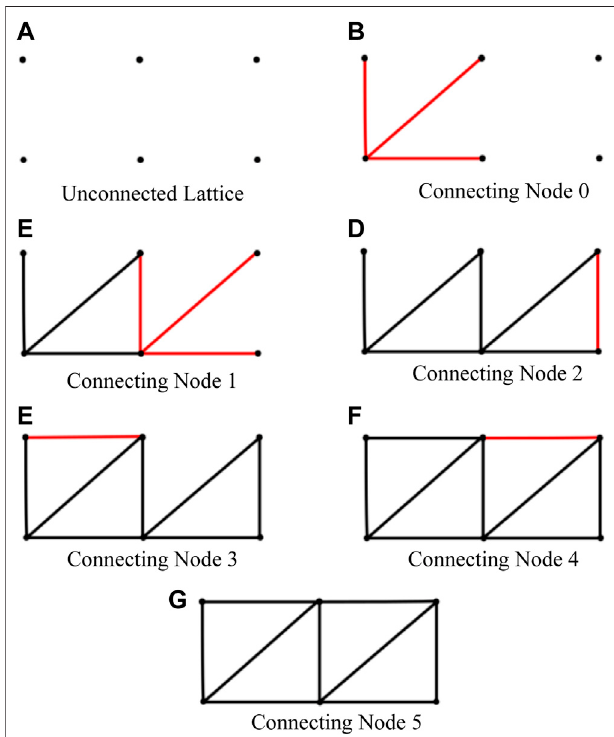
FIGURE 11 | Formation of 2 × 3 triangular lattice. (A) Unconnected lattice. (B) Connecting node 0. (C) Connecting node 1. (D) Connecting node 2. (E) Connecting node 3. (F) Connecting node 4. (G) Connecting node